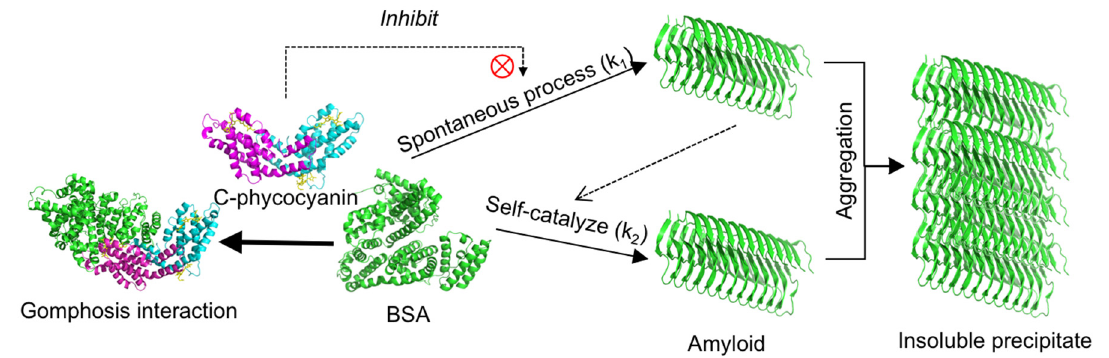
Figure 7. Mechanisms of phycocyanin inhibition on amyloid formation.